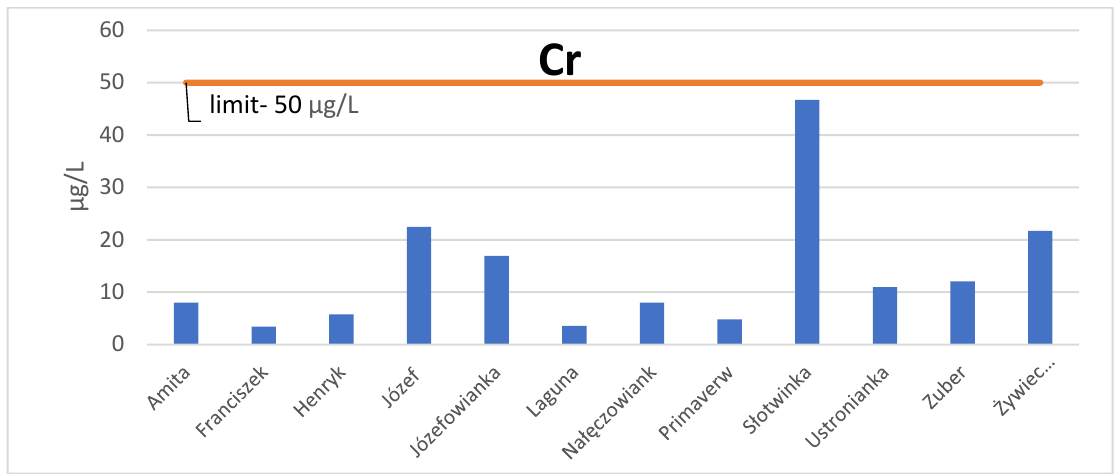
Figure 9. The concentration of chromium in mineral waters ( μg/L ).